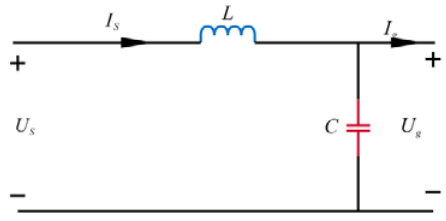
Figure 14. Topology for an LC low-pass